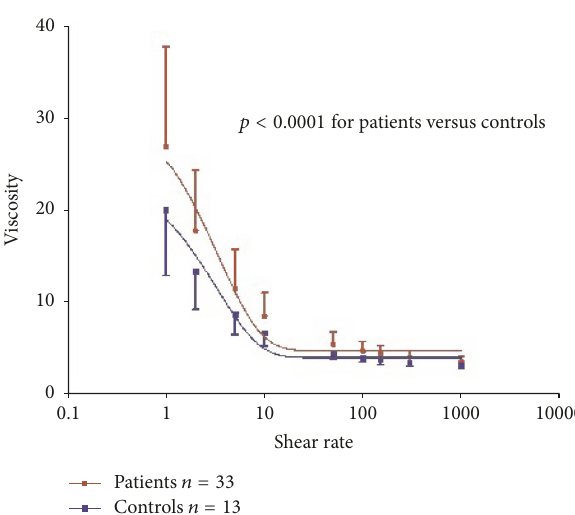
Figure 1: Whole blood viscosity compared between patients (red) and controls (blue) . WBV was significantly higher in the Systemic sclerosis group compared to healthy controls ( 𝑝 < 0.0001 ). This difference was most pronounced at shear rates between 1 and 10 s −1 ; however, shear rates were significantly different at all